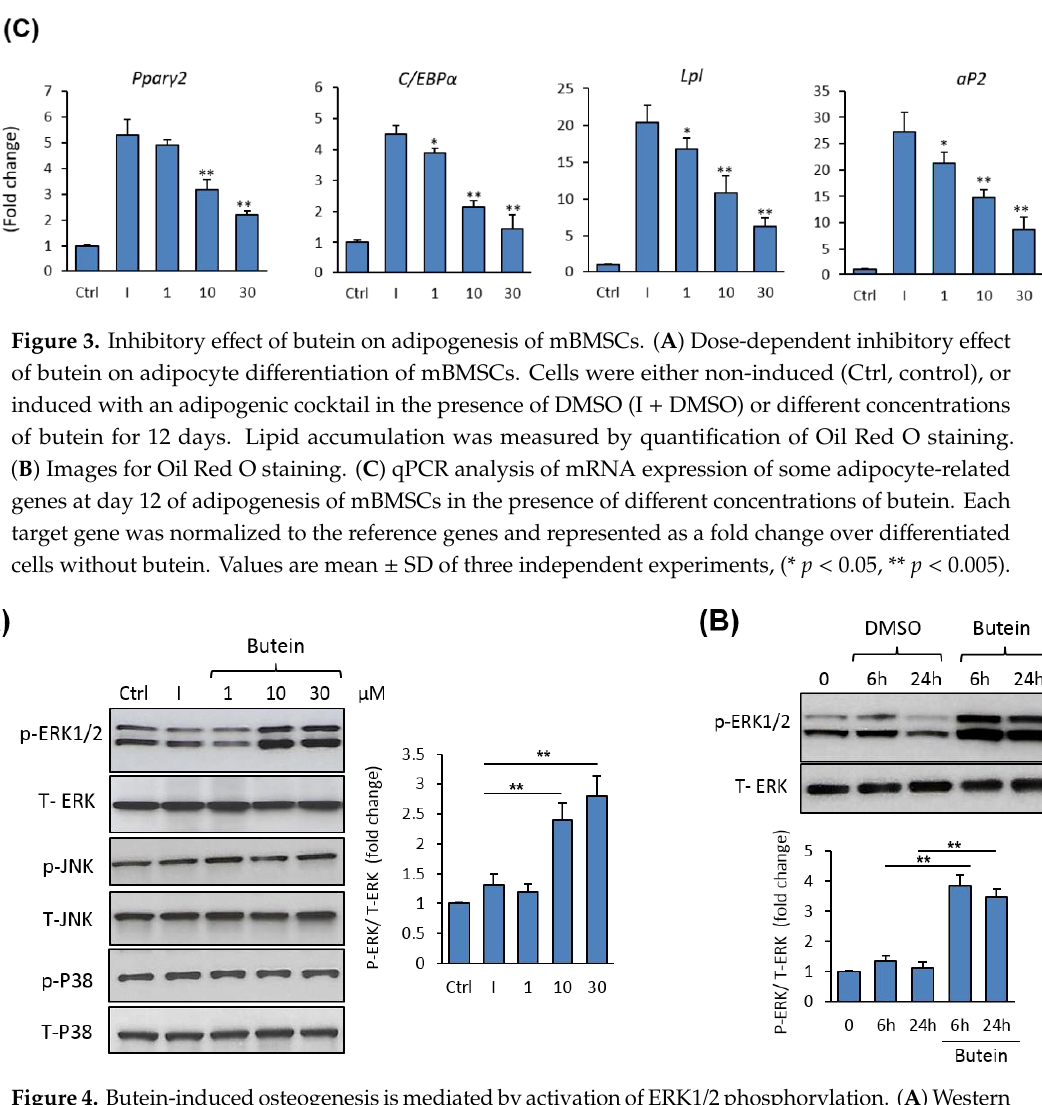
Figure 4. Butein-induced osteogenesis is mediated by activation of ERK1 / 2 phosphorylation. ( A ) Western blot analysis of MAPK protein expression (Total and phospho-activating extracellular signal-regulated kinase, T-ERK2 and p-ERK1 / 2; Total and phospho-Jun N-terminal kinase, T-JNK and p-JNK; and total and phospho-P38, T-P38 and p-P38), in mBMSCs treated with different concentrations of butein (1–30 µ M). Cells were induced with an osteogenic cocktail (as described in the Materials and Methods) in the absence of non-induced or in the presence of butein for 2 h. ( B ) Western blot analysis of the activation of ERK1 / 2 phosphorylation by butein in mBMSCs during osteogenesis. Cells were induced with an osteogenic cocktail in the absence or the presence of butein (30 µ M) at 6 h and 24 h. Intensity for pERK1 / 2 was normalized to total ERK and represented as a fold change over control cells. Values are mean ± SD of three independent experiments, (** p < 0.005 compared to cells without butein).